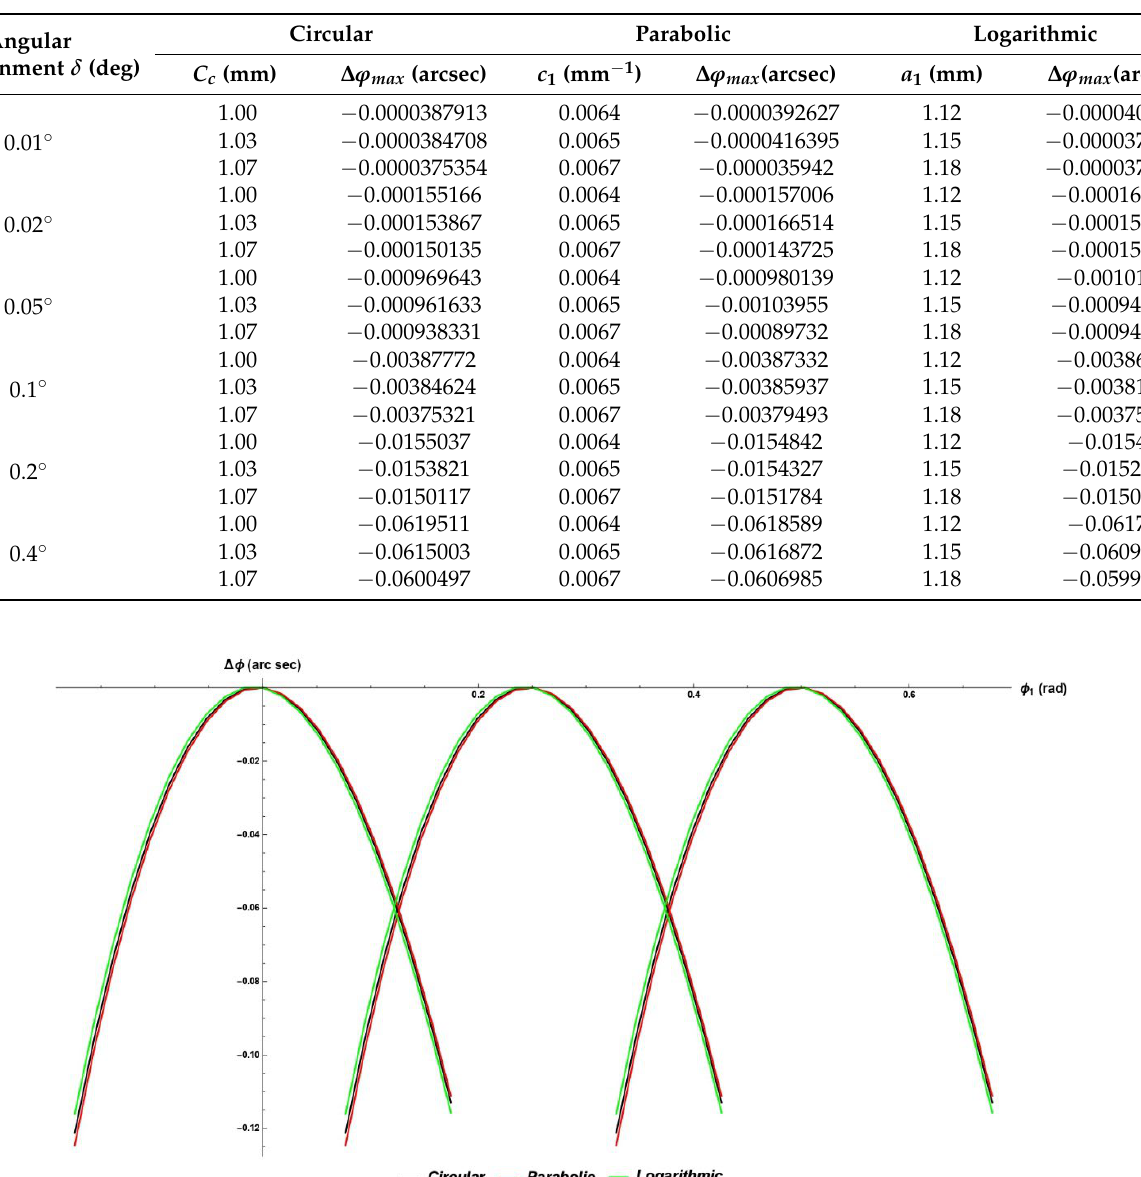
mm and the circular function by 0.048 mm.